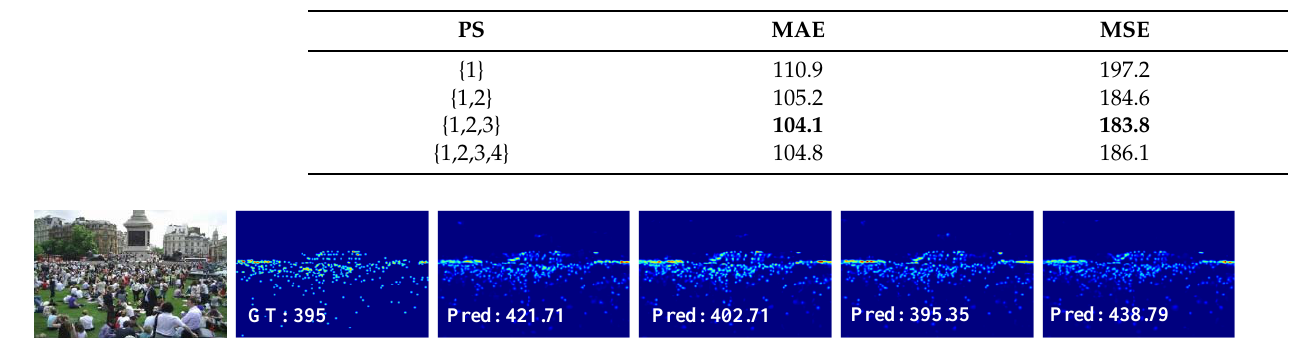
Figure 6. Impacts of different pyramid scale settings on UCF-QNRF. From left to right: input image, ground truth, result of PS = { 1 } , result of PS = { 1,2 } , result of PS = { 1,2,3 } , and result of PS = { 1,2,3,4 } .